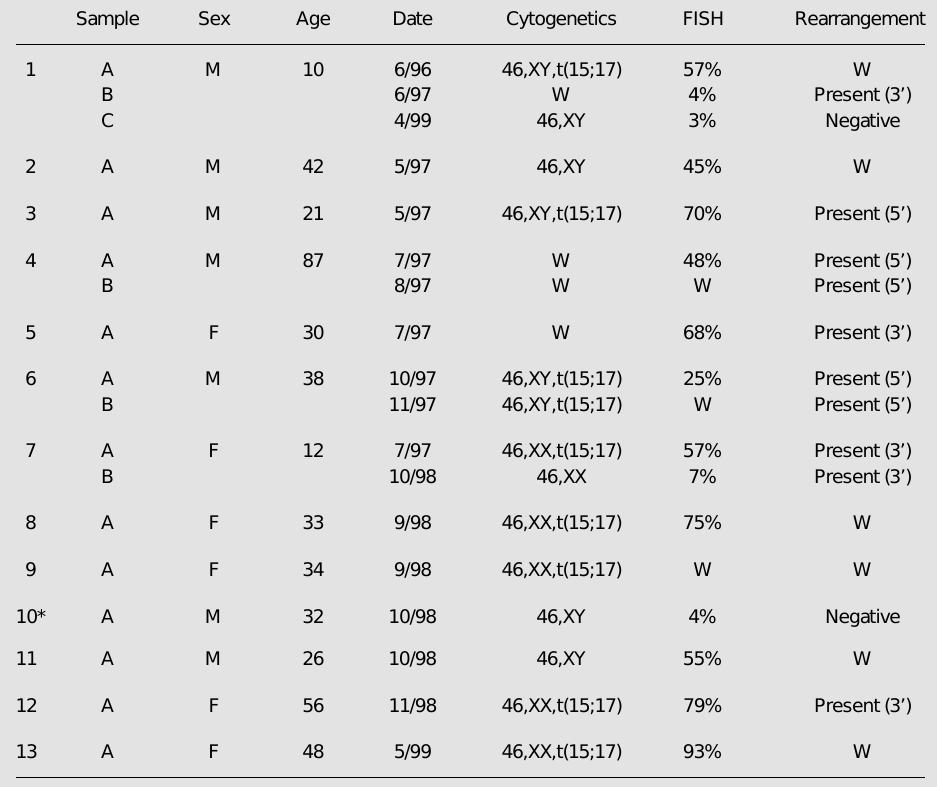
Table 1. Characterization of the cases studied: samples, sex, age, date of collection, results of karyotyping, FISH and RT-PCR considering the presence or absence of PML/RARA rearrangement at diagnosis or after therapy.